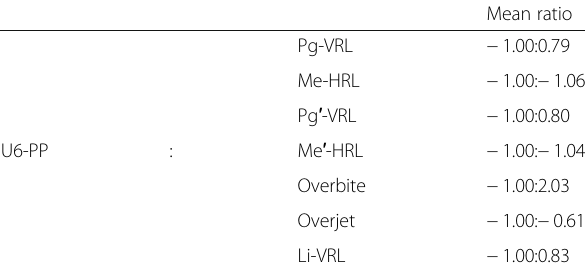
Table 3 Mean ratios between mean molar intrusion and selected variables